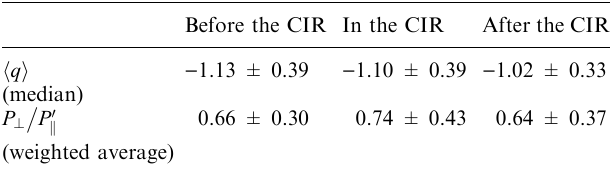
Table 1. Mean values of the spectral index and the ratios of the spectra before, during and after the CIR Before the CIR In the CIR After the CIR